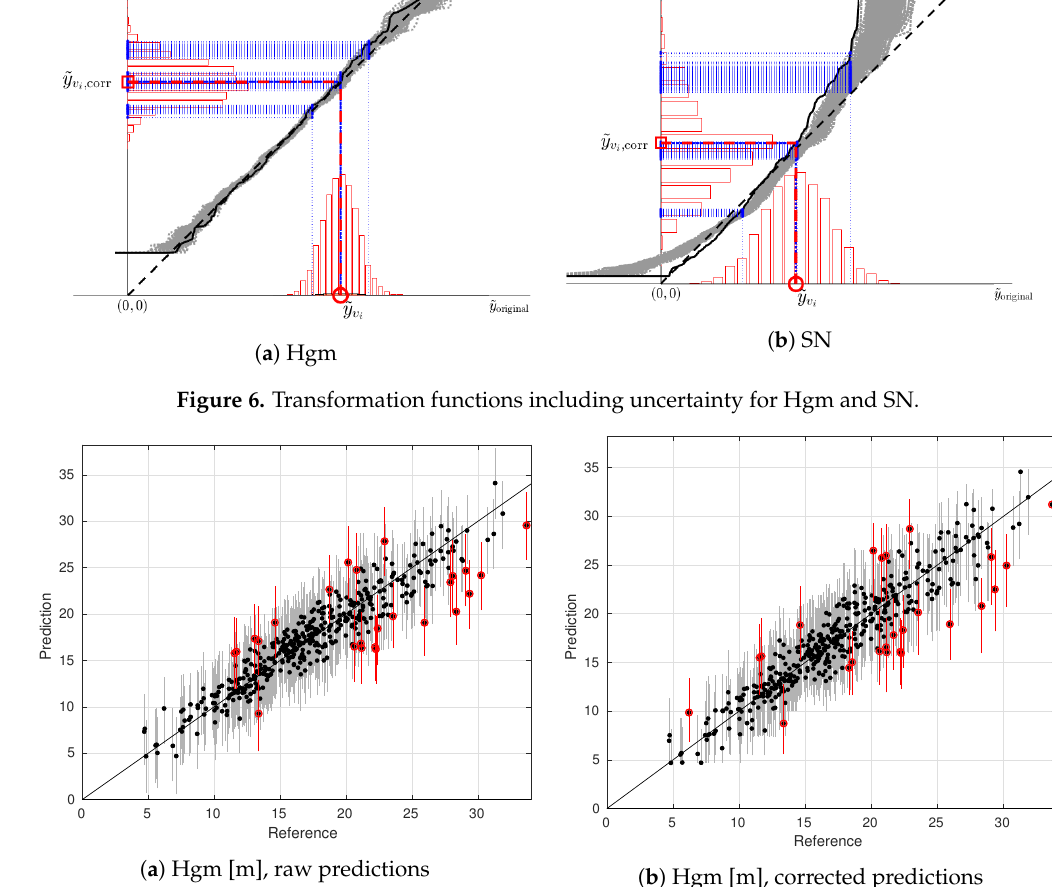
Figure 7. Hgm: Raw predictions, 7a, and corrected predictions, 7b with their 95% probability intervals (gray lines). The predictions for which the truth is outside the given 95% probability interval are shown with red color.